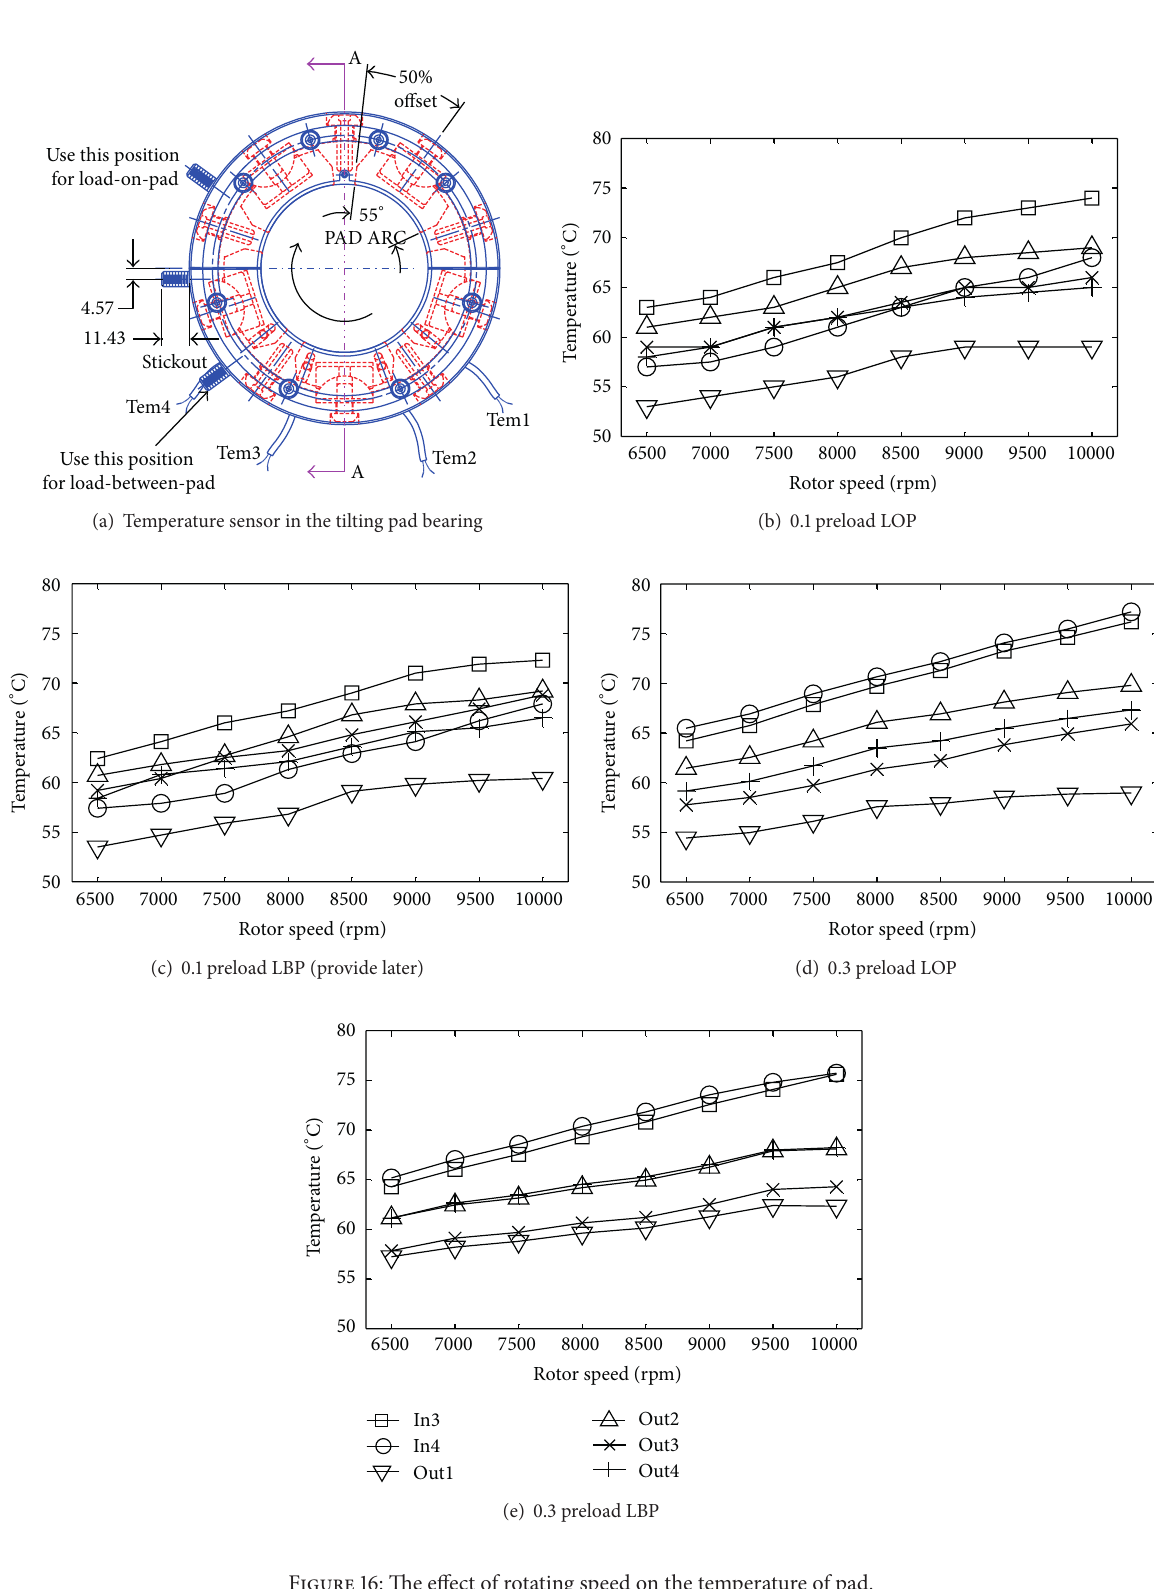
Figure 16: The effect of rotating speed on the temperature of